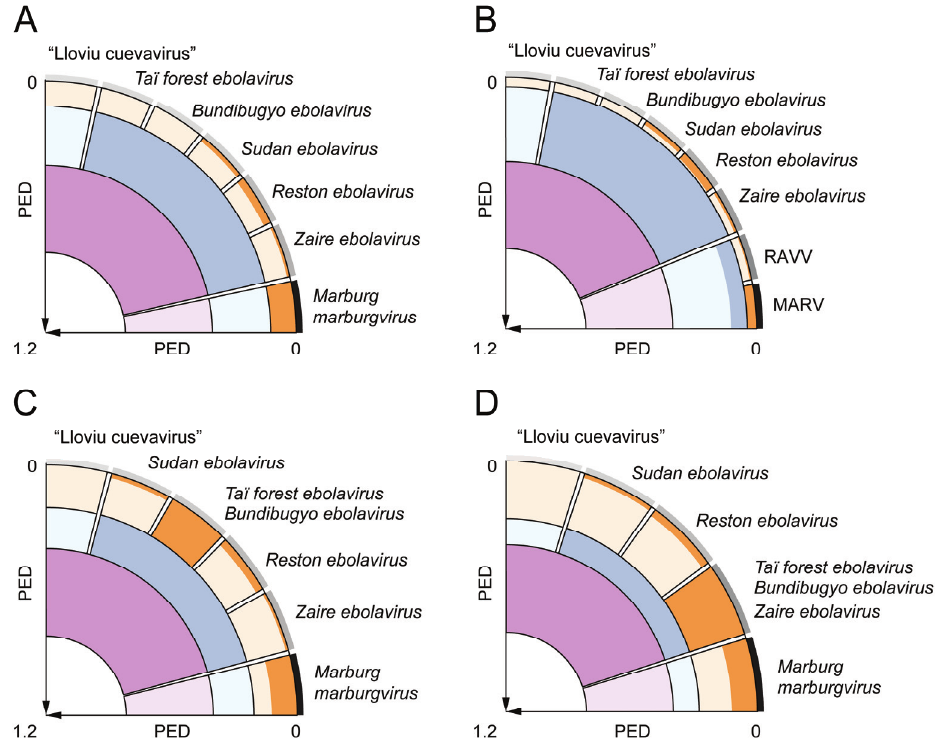
Figure 2. Genetics-based classification of filoviruses and alternative species groupings. A quadrant is used to visualize the classification of the 56 filoviruses with three hierarchical levels. The axes indicate intervirus genetic divergence (as PED) which increases linearly from the perimeter of the quadrant (zero PED) to its origin (maximum PED of 1.2). The three classification levels are highlighted using three basic colors (orange, blue, and purple). Each color exists in two shadings that highlight the limit on expected intragroup genetic divergence according to a distance threshold (soft shading) and the maximum observed intragroup genetic divergence (bright shading) of a cluster. ( A ) The genetics-based filovirus classification using the three top-ranked PED thresholds. It comprises seven, three, and two clusters, respectively, at the three hierarchical levels. The seven orange clusters of the lowest level correspond to the official or tentative ICTV species of the family Filoviridae [25] and are indicated by names. The three blue clusters correspond to the official or tentative ICTV genera of the family Filoviridae (from left to right: “Cuevavirus”, Ebolavirus , and Marburgvirus ); the two purple clusters correspond to supra-generic taxa currently not recognized in the ICTV filovirus classification. Outside the quadrant, the relative density of virus sampling per ICTV species is shown as gray shadings from low (light) to high (dark) sampling, which is in the range of 1 to 34. ( B ) An alternative classification with eight instead of seven clusters at the lowest level. It was derived by using the alternative species threshold at PED = 0.044. ( C ) An alternative classification with six instead of seven clusters at the lowest level. It was derived by using the alternative species threshold at PED = 0.204. ( D ) An alternative classification with five instead of seven clusters at the lowest level. It was derived by using the alternative species threshold at PED =